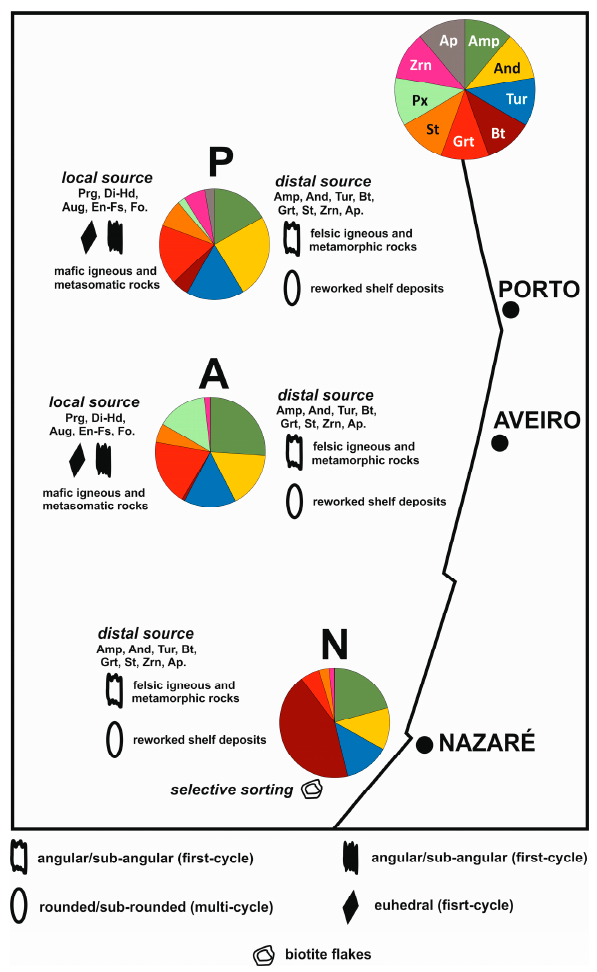
Figure 23. Heavy mineral source synthesis considering the 78 collected samples from the Porto (P), Aveiro (A), and Nazaré (N) areas. Distal and local sources are responsible for two different kinds of supplied minerals. The distal sources are responsible for the presence of angular mineral grains with fresh surface textures, considered as “first-cycle” detrital particles. They are also responsible for the presence of rounded mineral grains that are considered as “multicycle” detrital particles. The felsic igneous and metamorphic rocks of the Iberian Massif and derived terrigenous sediments are the main source of the angular mineral grains and the reworked relict-sedimentary deposits of the continental shelf are the main source of the rounded mineral grains. The mineral grains compatible with these distal sources are: amphiboles (Amp), andalusite (And), tourmaline (Tur), biotite (Bt), garnet (Grt), staurolite (St), zircon (Zrn), and apatite (Ap). Basic igneous rocks and thermal metamorphized dolomitic limestones are the most likely sources of the mineral assemblage derived from the local sources. This mineral assemblage is composed of diopside-hedenbergite (Dp-Hd), augite (Aug), enstatite-ferrosilite (En-Fs), pargasite (Prg) and forsterite (Fo). In the Nazar é area, a high concentration in biotite is observed due to the physical grain sorting of the lamellar mineral grains of this